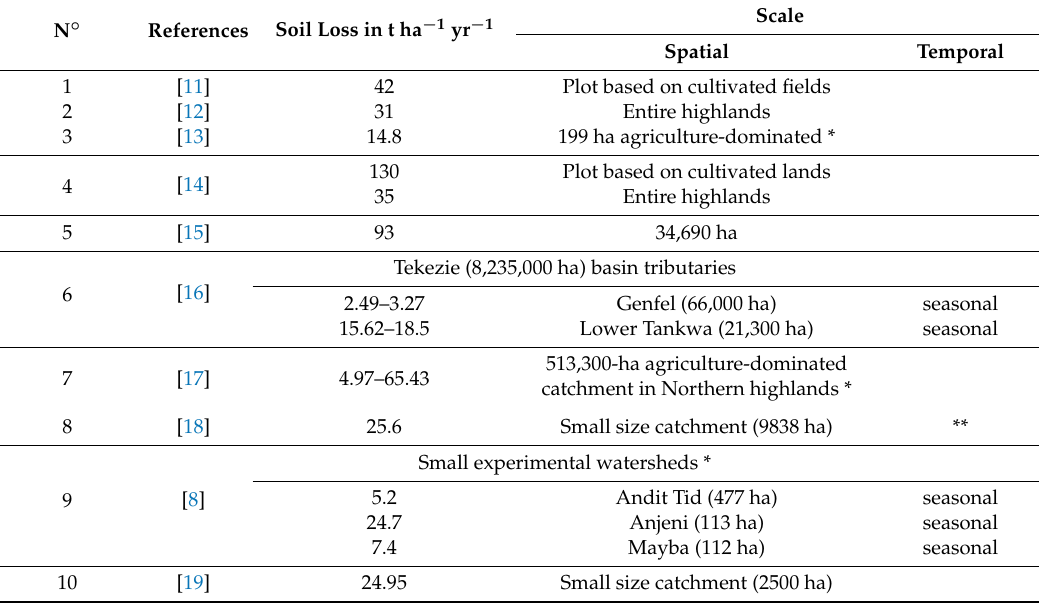
Table 1. Soil loss estimates from different studies in the Ethiopian